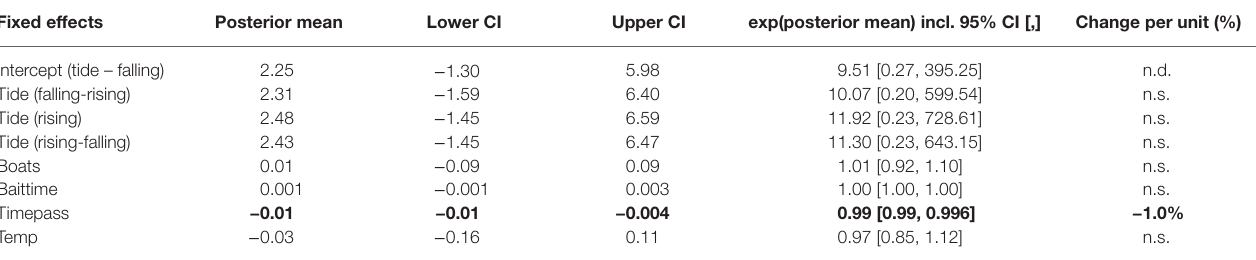
TABLE 3 | Summary of the generalized linear model (GLM) for the number of great hammerhead sharks ( S. mokarran ) during provisioning dives (model 2). Fixed effects